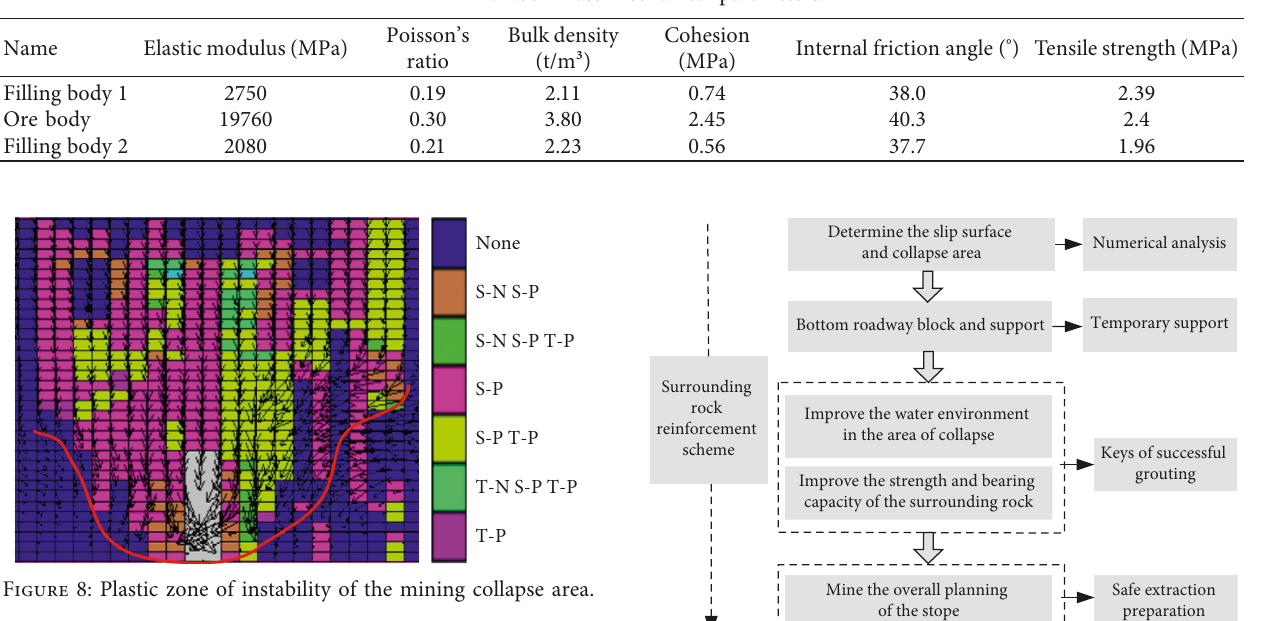
Table 1: Rock mass mechanical parameters.